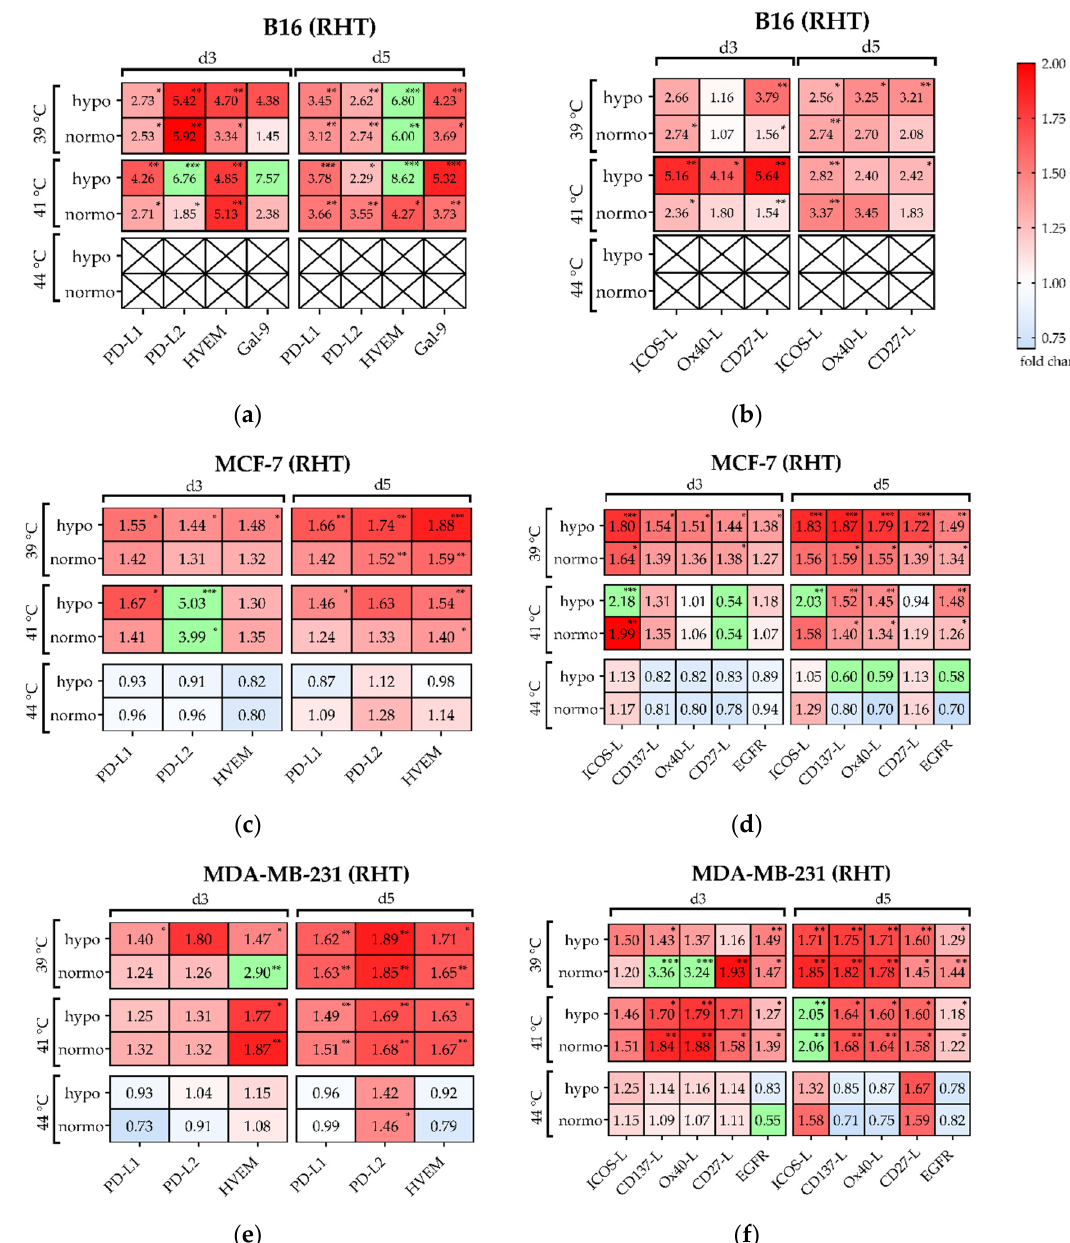
Figure 11. Heatmap of normalized expression (change in mean fluorescence intensity compared to mock-treated cells) of immune checkpoint molecules and of EGFR on day 3 ( d 3) and day 5 ( d 5) on the cell surface of ( a , b ) B16 melanoma and ( c , d ) MCF-7 breast cancer and ( e , f ) MDA-MB-231 breast cancer cells after hyperthermia at 39 °C, 41 °C or 44 °C and normo- and hypo-fractionated radiotherapy. Suppressive immune checkpoint molecules (PD-L1, PD-L2, HVEM) are presented in ( a , c , e ), while stimulatory immune checkpoint molecules (ICOS-L, CD137-L, Ox40-L, CD27-L) and EGFR are presented in ( b , d , f ). Green boxes are values of ∆ MFI <0.70 or ≥ 6.0 (a,b), and ∆ MFI <0.70 or >2.0 (c-f). Significance test was conducted using Kruskal-Wallis test with corrected Dunn’s multiple comparison from three independent experiments, each measured in duplicate. * ( p < 0.1), ** ( p < 0.01), *** ( p < 0.001).